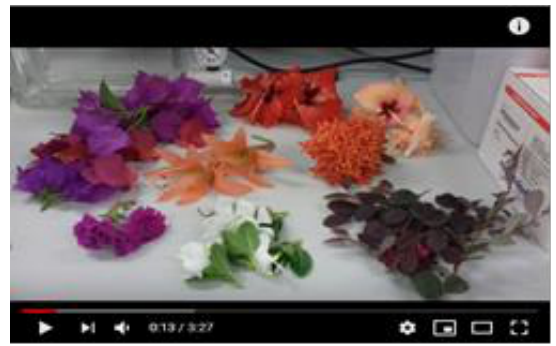
Figure 2: Food coloring as the study materials